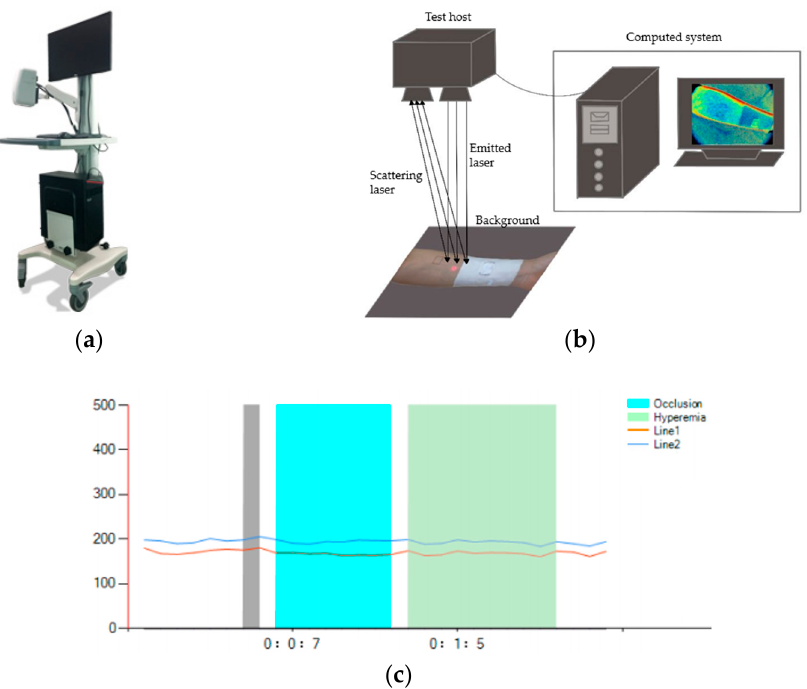
Figure 2. ( a ) The BVI microcirculation-blood-flow imager; ( b ) schematic diagram for measuring the blood-flow velocity of skin microcirculation on the surface of human body; ( c ) curves of blood-flow velocity of skin microcirculation on the surface of human body of a